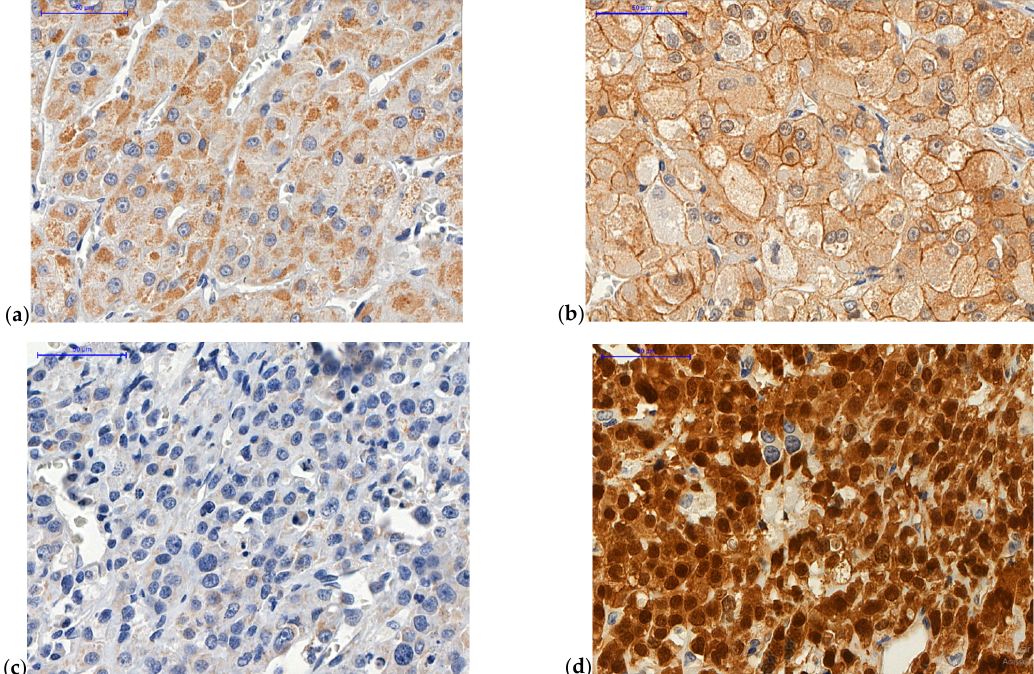
Figure 4. Figure of TMA: ( a ) ACC case 22 with high ZNRF3 cytoplasmic expression (score 5). Female patient, aged 19.3 y with hypercortisolism syndrome, a Weiss score of 4, and an ENSAT system score of 1. ( b ) ACC case 22 with membranous β -catenin expression. ( c ) ACC case 50 with low ZNRF3 cytoplasmic expression (score 0). Male patient, aged 36.1y with a silent tumor, a Weiss score of 8, and an ENSAT system score of 2. ( d ) ACC case 50 with cytoplasmic and nuclear β -catenin expression. Scale bar = 50 μ m. The Ki-67 proliferation marker showed positive correlation with tumor weight (coef- ficient 0.377; p = 0.01, Spearman’s rank correlation coefficient), tumor size (coefficient 0.344; p = 0.007, Spearman’s rank correlation coefficient), and the Weiss score (coefficient 0.572; p < 0.001, Spearman’s rank correlation coefficient). Furthermore, the categorization of Ki-67 into groups (<10%, ≧ 10% and <20%, ≧ 20%) impacted the OS analysis (X 2 (2) = 29.363; p < 0.001; Kaplan–Meier method and log rank test) (Figure 5). The Cox regression of OS from the analysis of Ki-67 expression showed an HR of 5.802 (95% CI, 2.447–13.726) for the Ki-67 expression grouped in ≧ 10% and <20% (Wald = 15.925; df1; p < 0.001; Cox’s proportional hazards model), and we calculated an HR of 9.041 (95% CI, 3.543–23.073) for the Ki-67 expression grouped in ≧ 20% (Wald = 21.217; df1; p < 0.001; Cox’s proportional hazards model). Figure 5. Ki-67 proliferation marker—OS Kaplan–Meier curve.